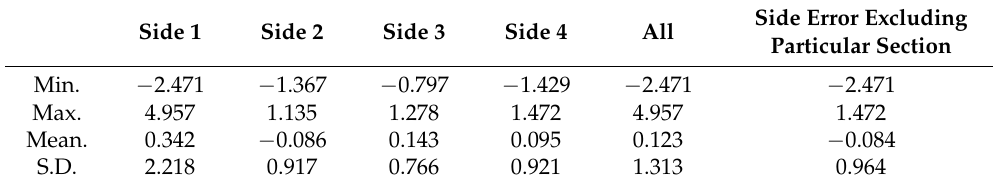
Table 3. Side error of FCP (unit: mm).